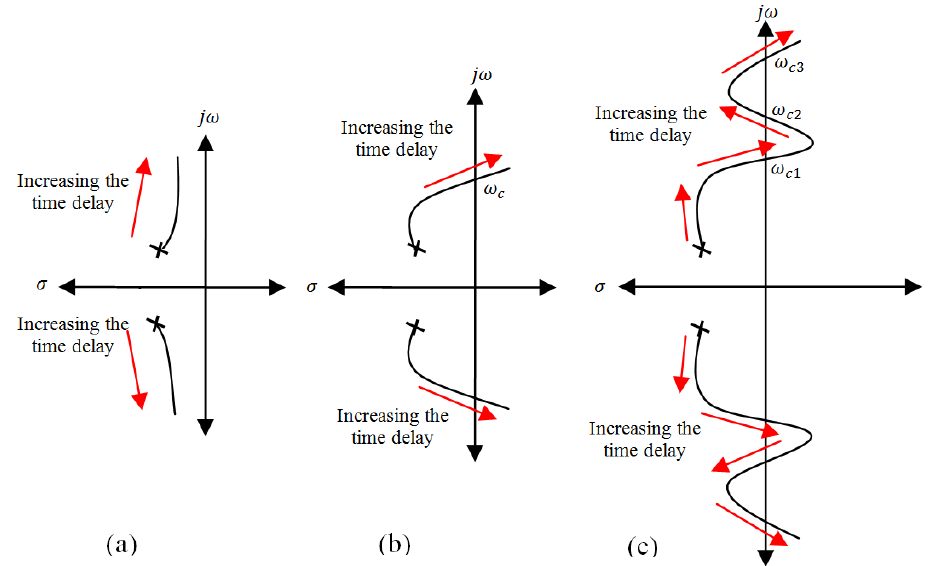
Figure 1. ( a ) A delay-independent system, ( b ) a delay-dependent system with a single delay margin, and ( c ) a delay-dependent system with multiple delay margins.